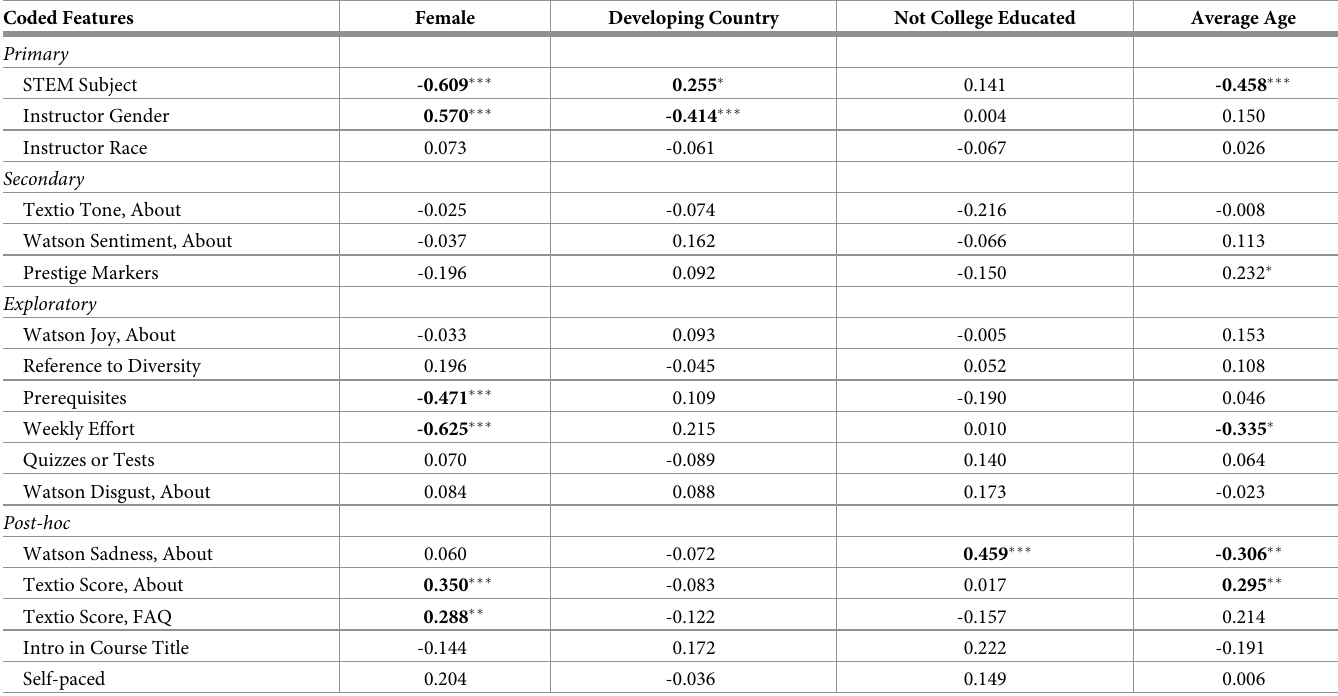
Table 2. Confirmatory and exploratory findings in the Stanford